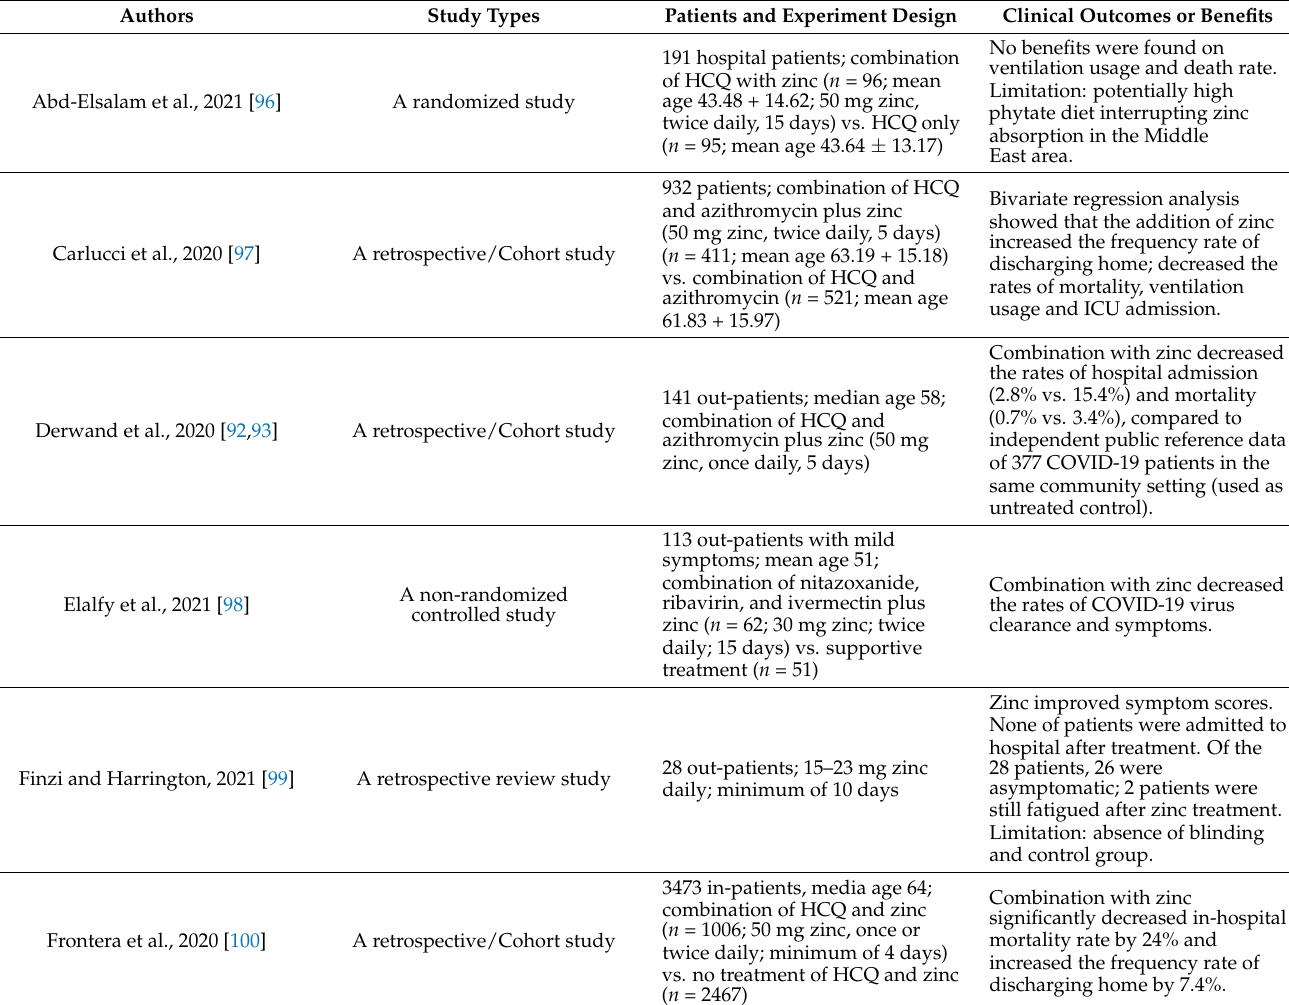
Table 2. Clinical outcomes or benefits of zinc treatment in